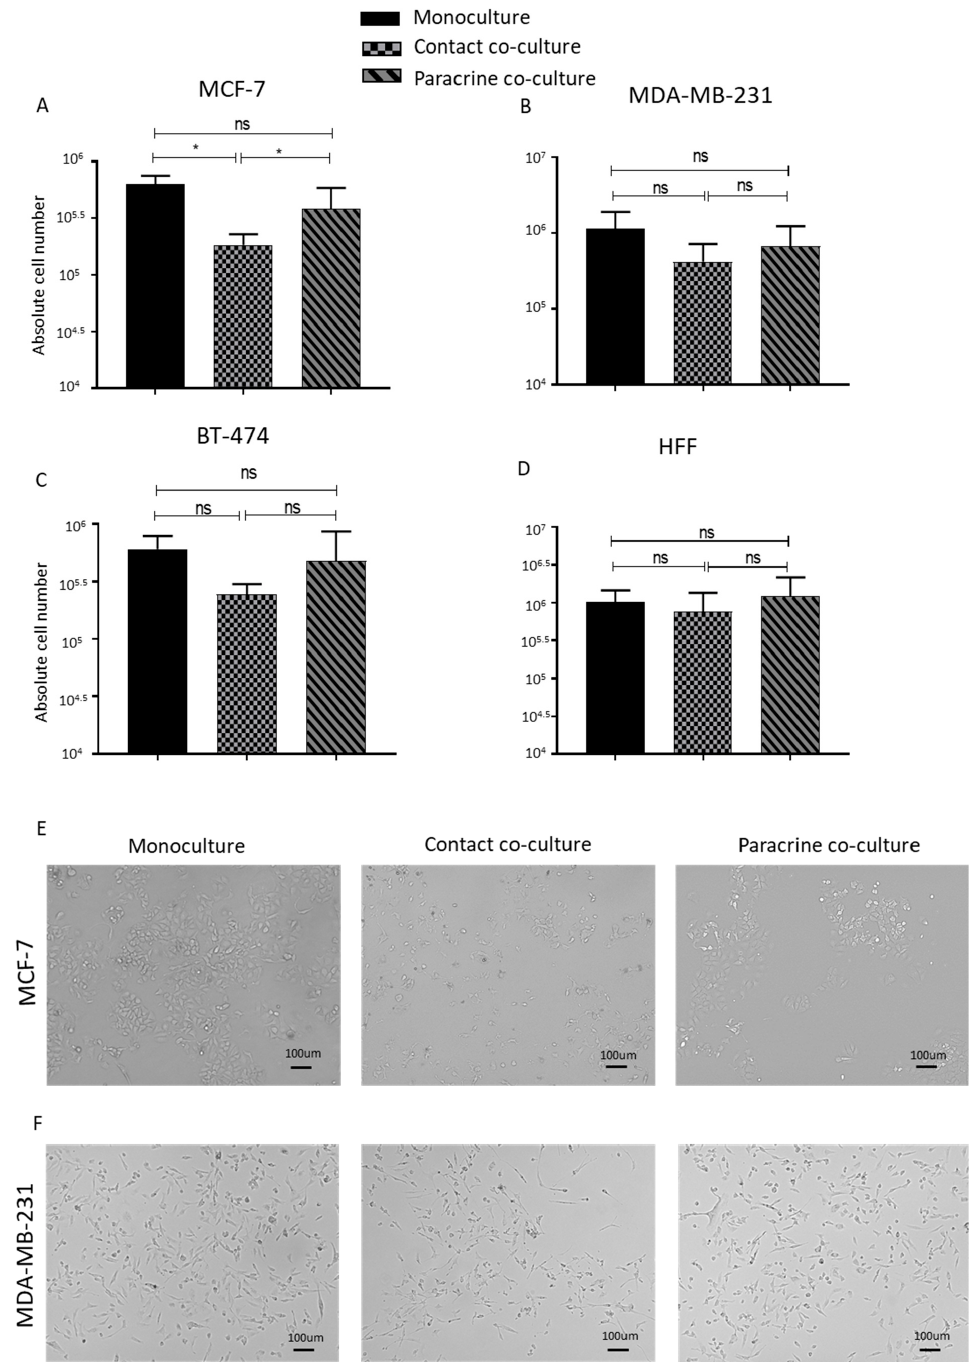
Figure 2. Contact and paracrine co-culture of lipoaspirate do not promote breast cancer cells’ proliferation. ( A – D ) Absolute cell count obtained using Neubauer counting chamber after 4 days of either contact or paracrine co-culture of lipoaspirates with MCF-7 ( A ), MDA-MB-231 ( B ), BT-474 ( C ), or human foreskin fibroblast (HFF) ( D ). Graphs are representative of the results obtained using lipoaspirate from 3 di ff erent donors. p value < 0.05 = *, ns = non-significant. ( E , F ) Bright field microscope images of contact and paracrine co-culture of MCF-7 and MDA-MB-231 cells with